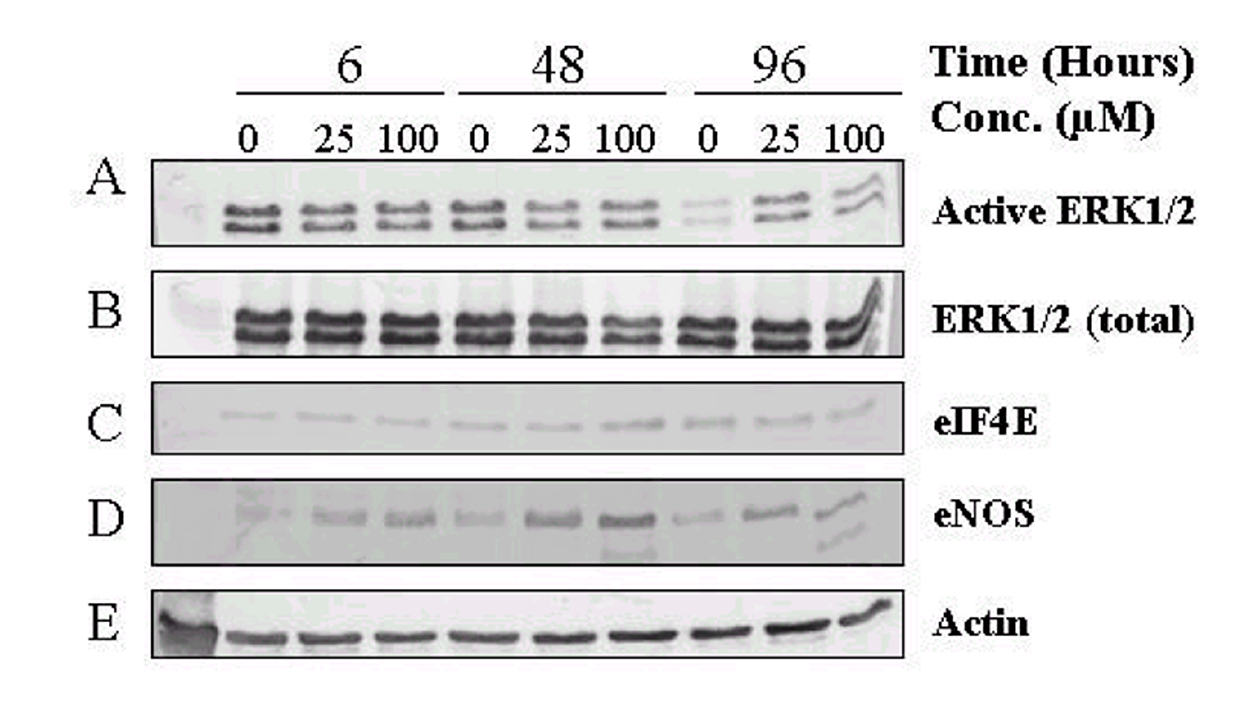
Figure 5 Biochemical changes in resveratrol-treated BPAEC. BPAEC were treated with the indicated concentrations of resveratrol and lysed after 6, 48, and 96 h, respectively. Lysates were run under 10% SDS-PAGE, and probed with antibodies for the various target proteins. Panel A. Changes in activated ERK1/2-P (representative of 3 experiments). Panel B. Changes in ERK1/2 (repre- sentative of 2 experiments). Panel C. Changes in eIF-4E. Panel D. Changes in eNOS. Panel E. Changes in actin. Lanes 1,4,7 cor- respond to control at 6, 48, and 96 h; lanes 2,5,8 correspond to BPAEC treated with 25 µ M resveratrol for 6, 48, and 96 h; lanes 3,6,9 correspond to BPAEC treated with 100 µ M resveratrol for 6, 48, and 96 h. The results represent the average of two experiments, each analyzed in duplicate or